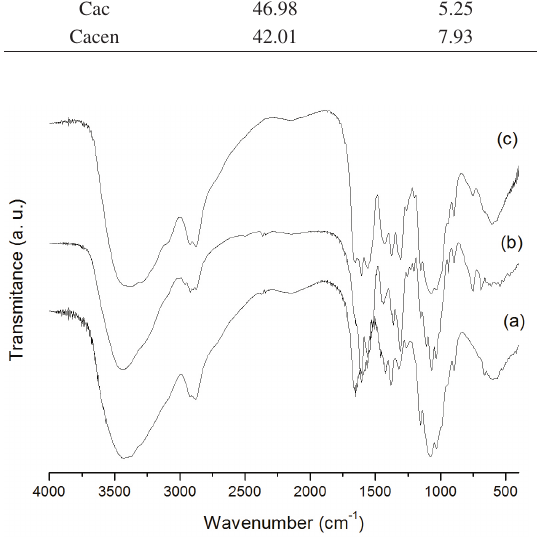
Figure 2. FTIR of the Cpure (a), Cac (b) and Cacen (c). Figure 3. NMR 13 C of the Cpure (a), Cac (b) and Cacen